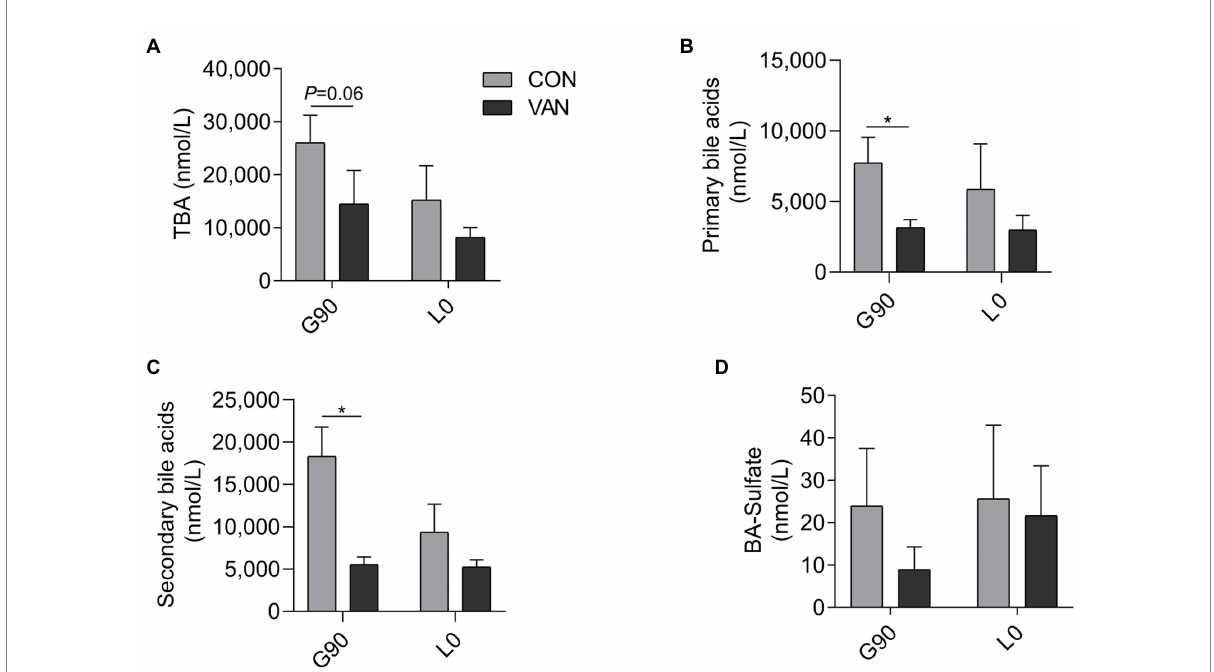
FIGURE 2 Comparison of maternal serum (A) TBA through calculated all individual BA through UPLC-MS/MS, (B) primary BA, (C) secondary BA, and (D) BA- Sulfate after VAN treatment at G90 and L0, respectively. Data are shown as means ± SE, * p <